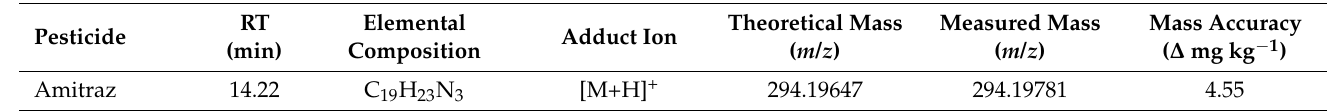
Table 1. High-performance liquid chromatography-high resolution mass spectrometry (HPLC-HRMS) parameters of amitraz, N -(2,4-Dimethylphenyl)formamide (2,4-DMF) and 2,4-Dimethylaniline (2,4-DMA) used for their determination in honeybee